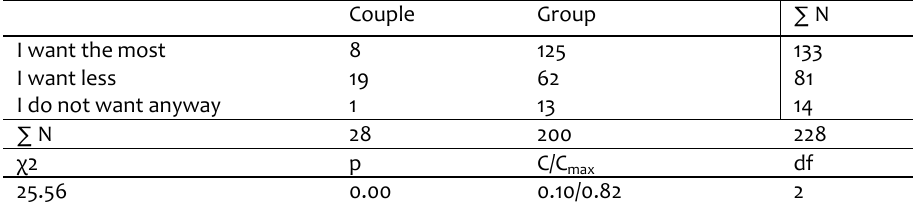
Table 4: Social status of students and physical activity in groups or pairs Couple Group ∑